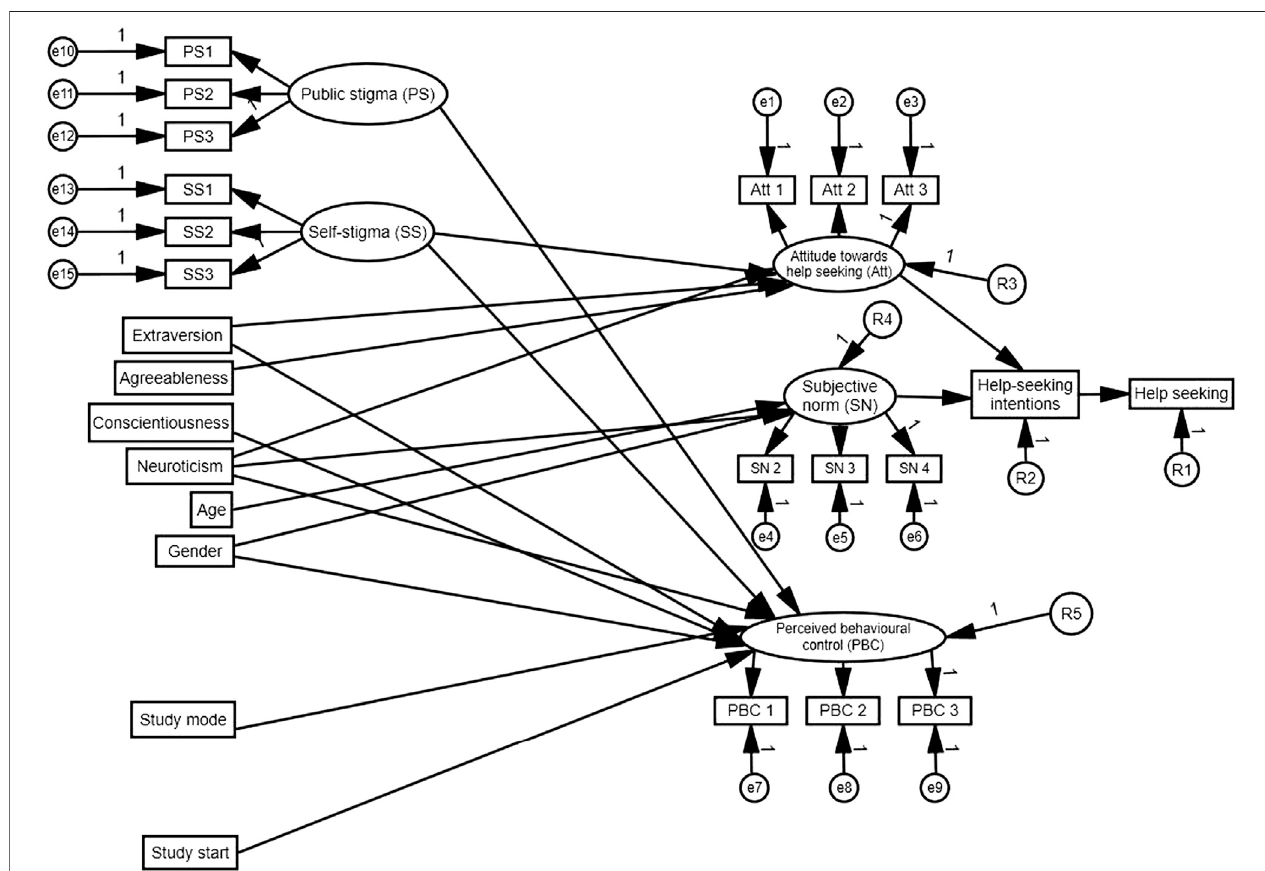
FIGURE 3 | Modi fi ed model with improved yet insuf fi cient model fi